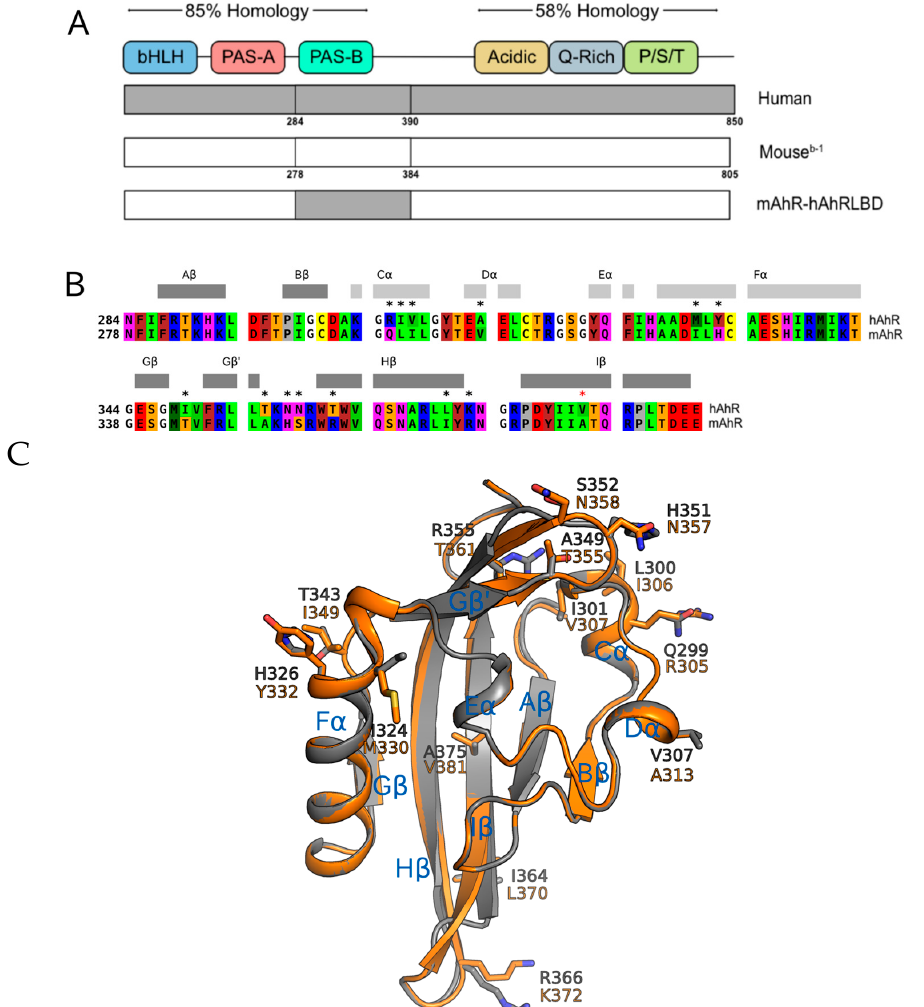
Figure 4. Comparison of the AhR PASB ligand binding domain of the human and mouse AhR. ( A ) Structural domains of the hAhR (850 aa), mAhR (805 aa) and chimeric mAhR-hAhRLBD (811 aa) proteins; ( B ) Sequence alignment of the mAhR and hAhR PASB LBDs with non-consensus residues indicated by asterisks (red asterisk for the internal different residue). Coloring scheme for residues: red, acidic; blue, basic; purple, polar; yellow, Cys; brown, aromatic; green, hydrophobic; orange, Ser, Thr; gray, Pro; white, Gly. Secondary structure elements according to DSSP for the modeled AhR LBDs are reported above the sequences (helices: light gray; β -strands: dark gray) and labeled with the PAS structure nomenclature; ( C ) Cartoon representation of the AhR LBD homology models (structural superposition of: mAhR, in gray, hAhR, in orange). Nonconserved residues are shown as sticks. Secondary structure elements are labeled with the PAS structure nomenclature.